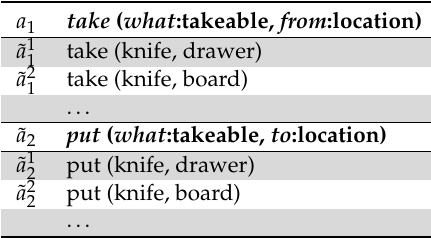
Table 2. Result of step 2: The table lists the type signature and each possible instantiation for the set of actions identified in the previous step. Here “what: takable” denotes any entity from type “takable”, similarly “from: location” denotes any entity of type location.